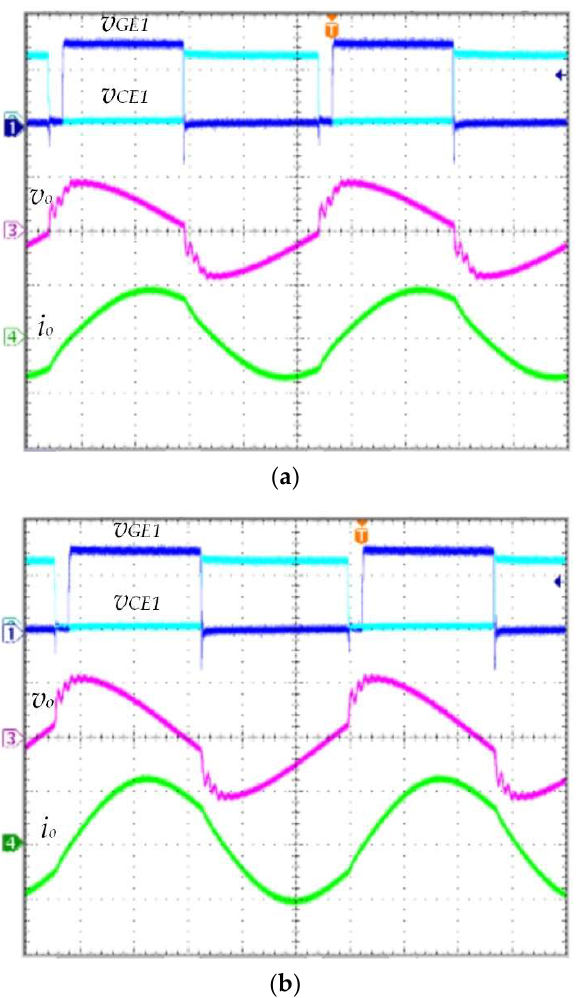
Figure 21. Hardware experimental waveforms v GE1 (duty cycle), the voltage across the power switch voltage v CE1 , the output voltage v o , and the output current i o under the condition that the workpiece is 500 °C: ( a ) traditional control strategy, ( b ) proposed MPPT heating control strategy. ( v GE1 : 10 V/div; v CE1 : 200 V/div; v o : 40 V/div; i o : 40 A/div; and Hor: 4 μs/div).